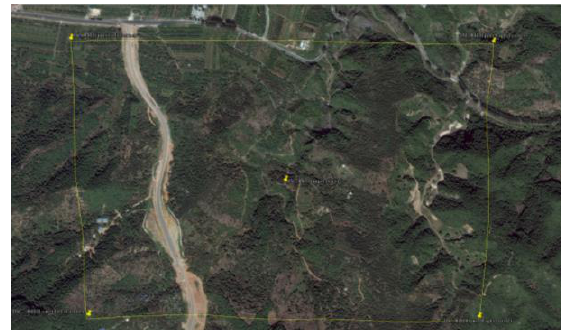
Figure 10. The direct georeferencing of an UAV image Figure 11 shows the footprints of the images dynamically overlaid on the textured DEM in the presented system. The area covered by each image can be immediately determined. The user can navigate the area in 3D and interactively select the interest area/point and view the UAV images that cover the